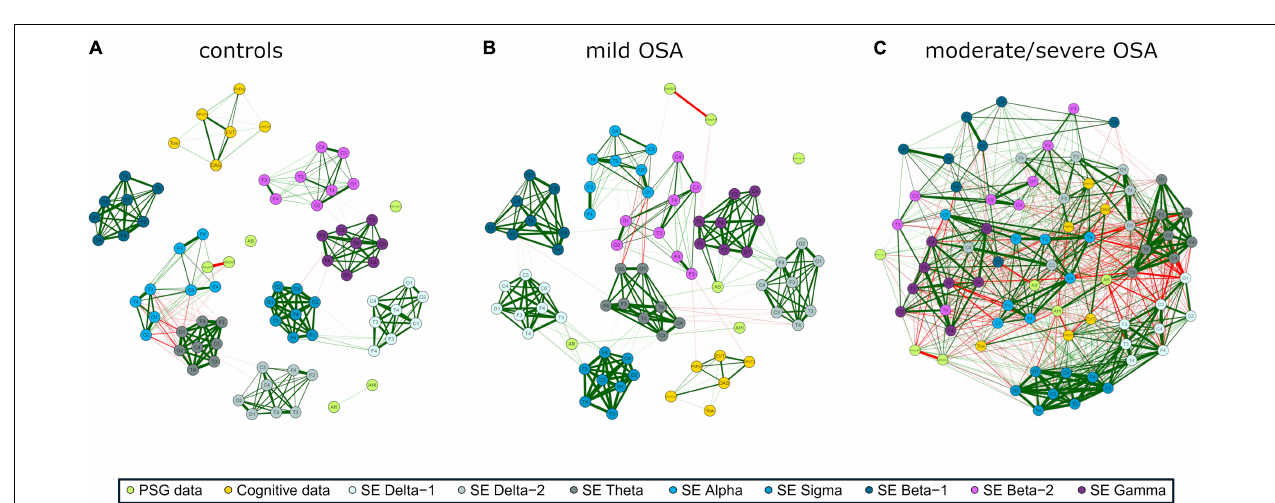
FIGURE 2 | EEG activity ( RP ) correlation networks with polysomnography (PSG) variables [apnea–hypopnea index (AHI), AE, respiratory event-related arousals (AR), minimum oxygen saturation value (Nadir SpO 2 ), the number of minutes awake after sleep onset (WASO), and sleep efficiency (SleepEff)] and cognitive scores [differential ability scales (DAS), Peabody Picture Vocabulary Test (PPVT3), Expressive Vocabulary Test (EVT), design copying (DesCop), phonological processing (PhPro), and Tower (Tow)] for (A) controls, (B) mild OSA, and (C) moderate/severe OSA. Wider edges are higher Spearman’s correlation absolute values | ρ |, with red color meaning negative correlation and green positive correlation. Solid lines represent | ρ | ≥ 0.50.